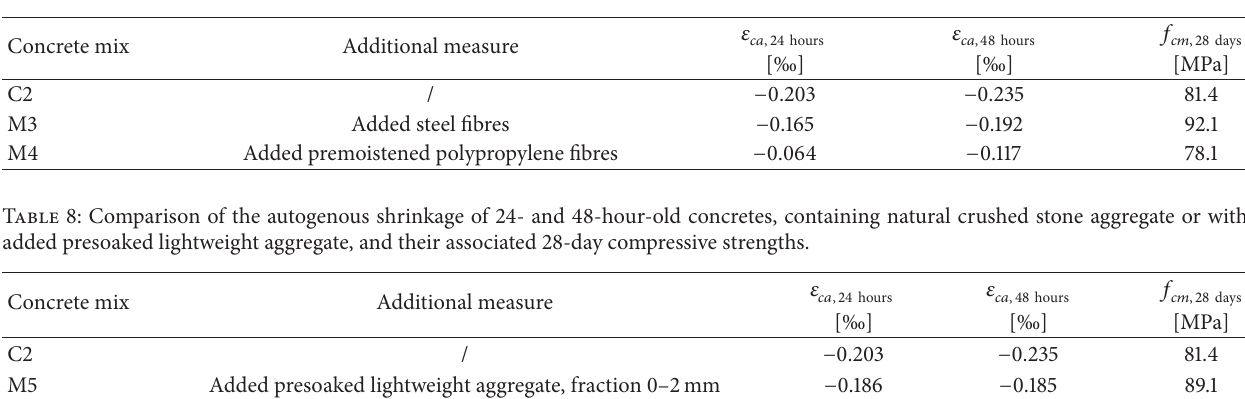
Table 7: Comparison of the autogenous shrinkage of 24- and 48-hour-old non-reinforced and fibre-reinforced concretes, and their associated 28-day compressive strengths.